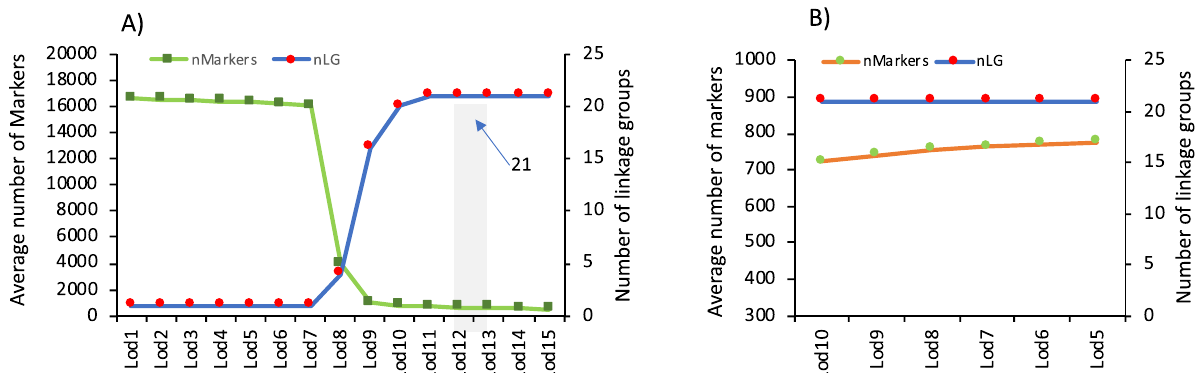
Figure 1. Selection of LOD score limit (Lod) to construct genetic map in LepMap3. ( A ) The average of number of markers (nMarkers) positioned in linkage groups (left Y axis) and the number of linkage groups (nLG; right Y axis) for Lod values from 1 to 15 as implemented in the "SeparateChromosomes” module. Lod11 (shaded) indicates the value selected that grouped the markers in 21 LGs. ( B ) Average number of markers recovered